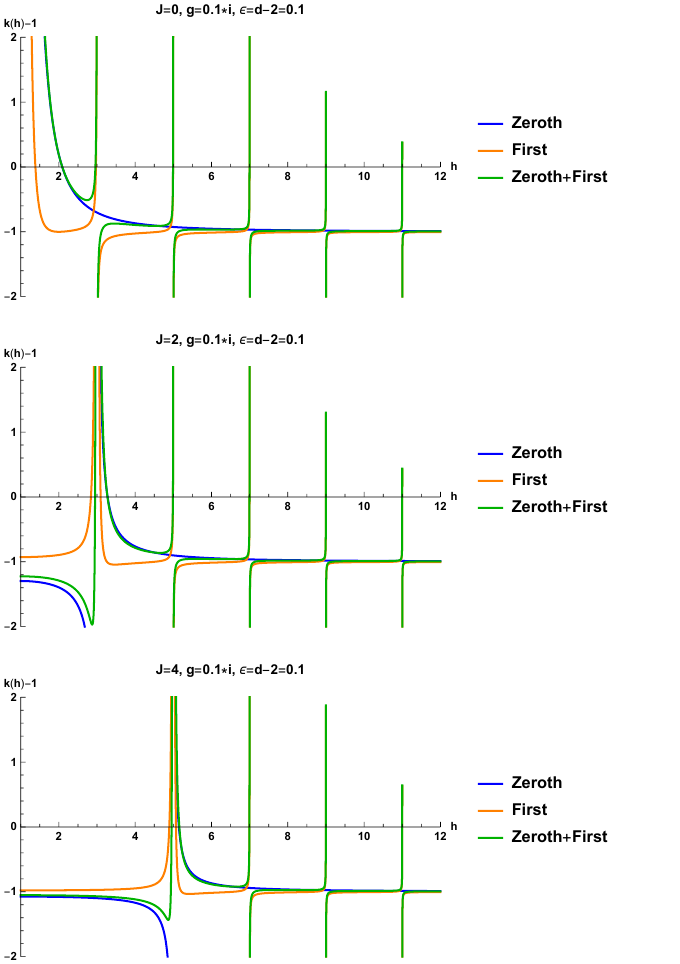
1 around d = 2 with g = 0 : 1 i , and J = 0 ; 2 ; 4. The blue lines represent (cid:0)